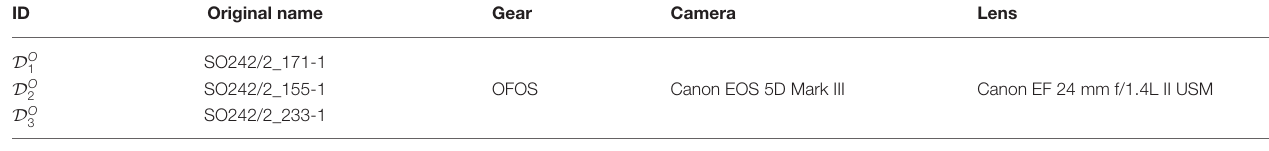
TABLE 1 | The four data sets were recorded with two kinds of gear (OFOS and AUV) and different camera set ups.